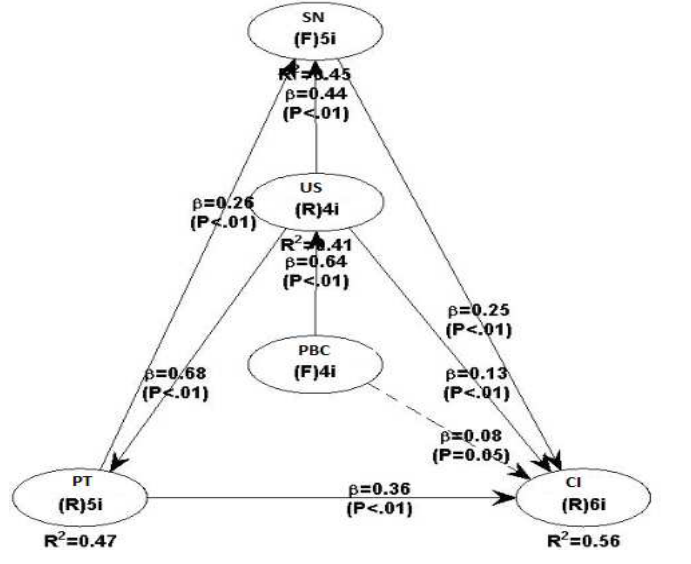
Fig. 2. Empirical result of testing the